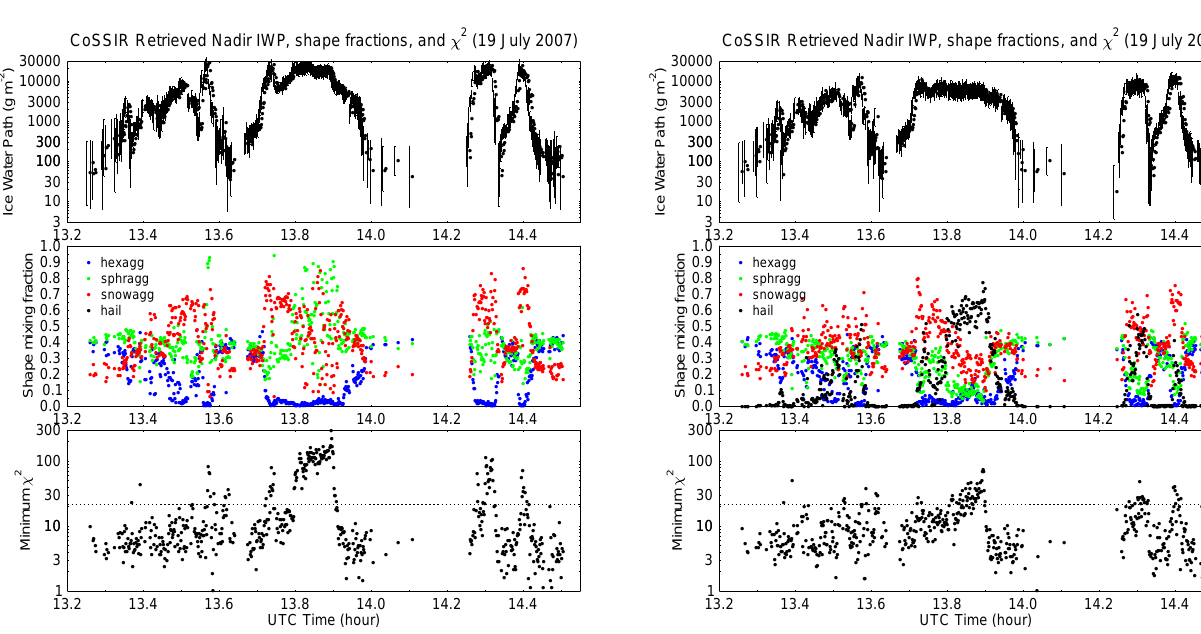
old of 0.95 is chosen to indicate cloud. The retrieved ice wa- ter path, D me , and median IWP cloud height, all with error bars, for the cloudy pixels on 19 July are shown in Fig. 8. Over the 568 cloudy pixels, the IWP ranges from 35 g m − 2 to about 11 000 g m − 2 (1 to 99 percentiles), while the D me ranges from 82 µm to 665 µm. The retrieved IWP error bars (one sigma in ln (IWP)) tend to be smaller for larger IWP and range from 0.21 to 1.8. The high altitude cirrus around 15.2 h is retrieved due to the small brightness temperature depressions at 640 and 874 GHz, as no depression is seen at 220 GHz.